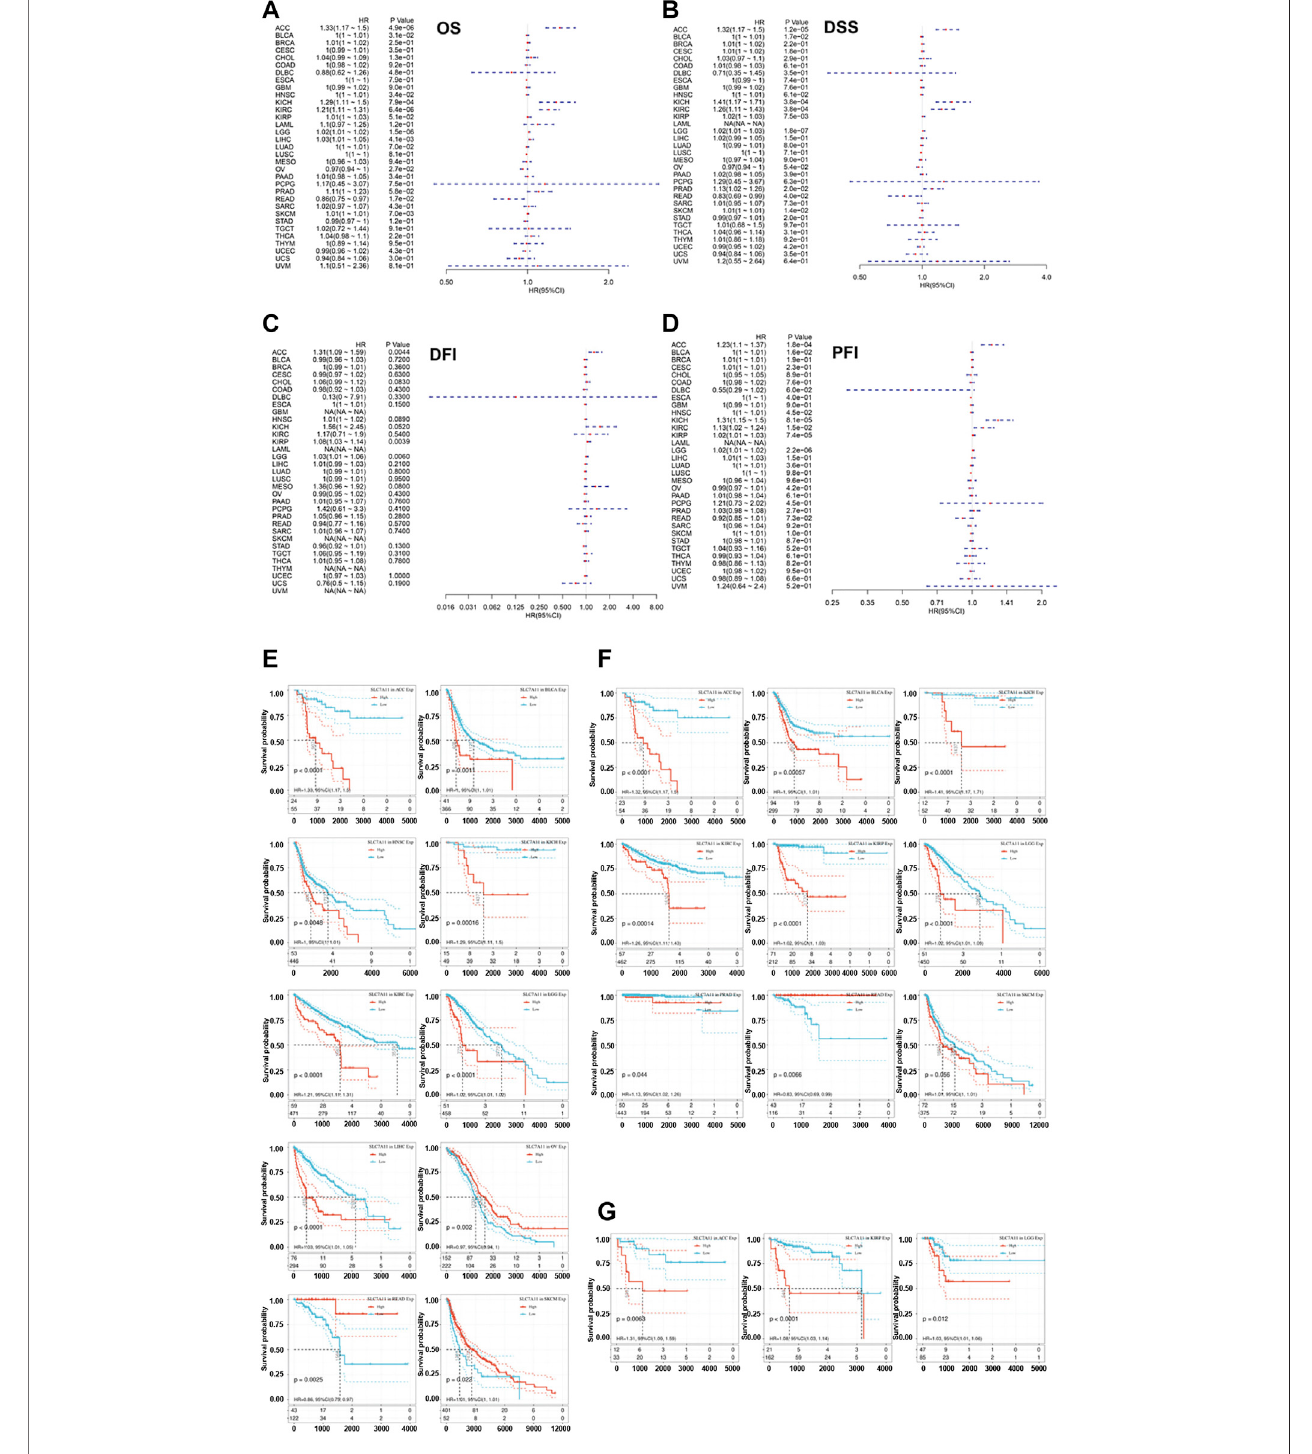
FIGURE 2 | Correlation of the expression of SLC7A11 with the prognosis of distinct cancers. (A) The association between SLC7A11 level and overall survival of cancers. (B) The association between SLC7A11 level and disease-speci fi c survival of cancers. (C) The association between SLC7A11 level and disease-free interval of cancers. (D) The association between SLC7A11 level and progression-free interval of cancers. (E – G) The survival curve revealed that SLC7A11 is signi fi cantly associated with the prognosis of several cancers.